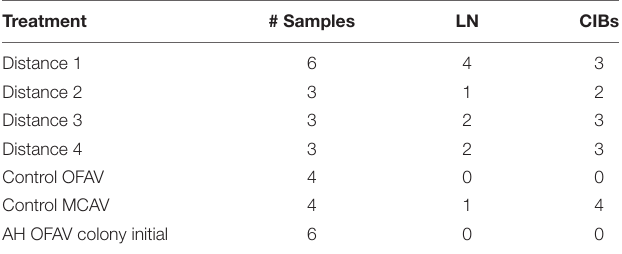
TABLE 4 | Histological samples examined for baseline lytic necrosis (LN) and crystalline inclusion bodies (CIBs) in M. cavernosa donors prior to the M. cavernosa to O. faveolata disease induction